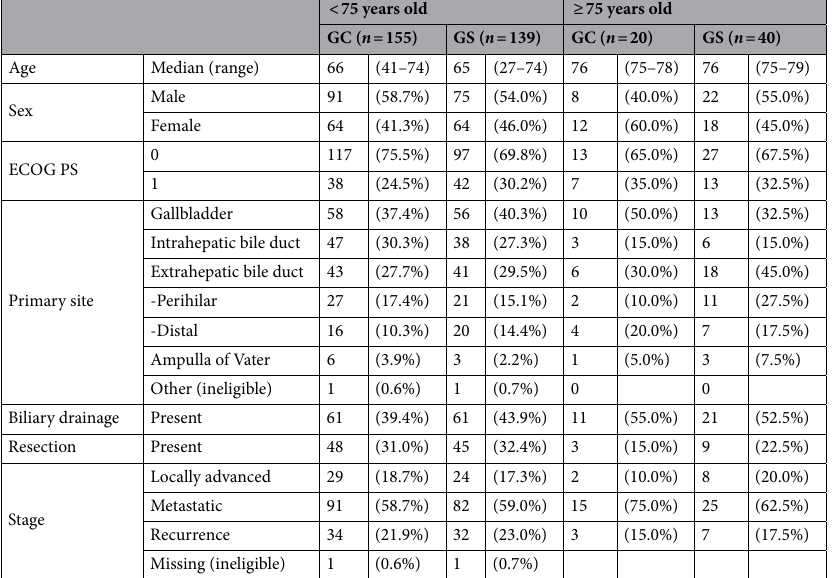
Table 1. Baseline characteristics (intention-to-treat population). ECOG PS, Eastern Cooperative Oncology Group performance status; GC, gemcitabine plus cisplatin; GS, gemcitabine plus S-1.